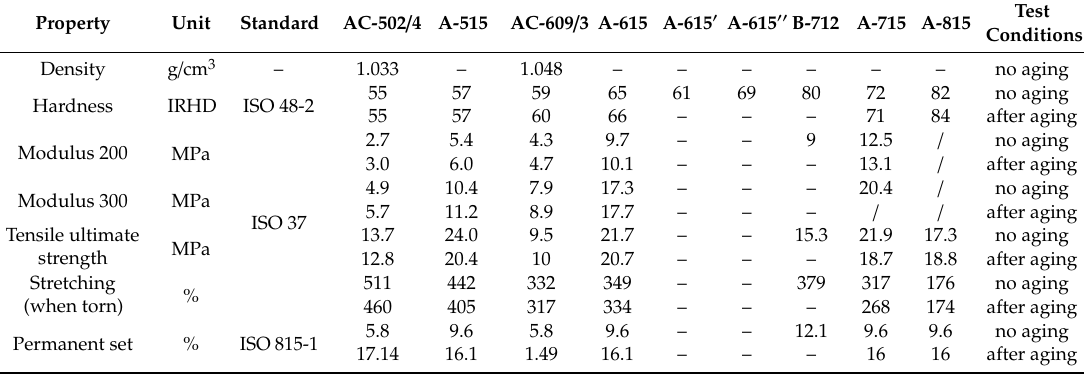
Figure A1. Implementation of Bergström–Boyce constitutive model via the ANSYS software command interface. Table A1. Mechanical properties of compounds used in research.